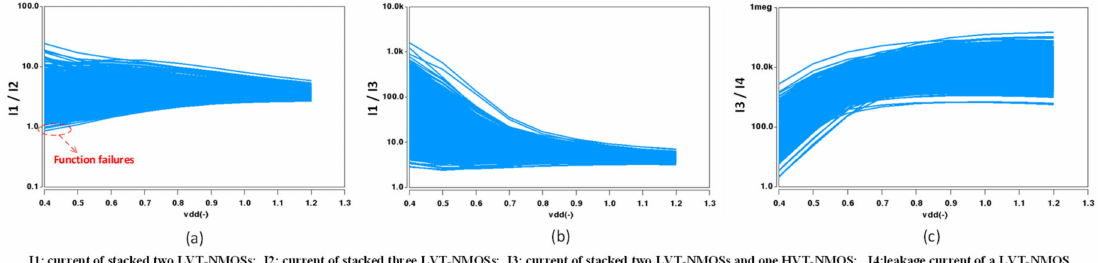
Figure 8. Function failure analysis.